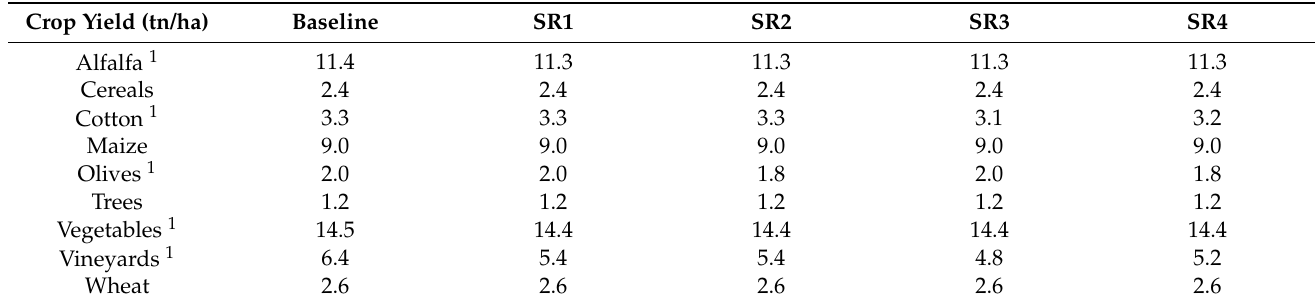
Table 6. Mean annual crop yields in (tn/ha) for the various scenarios (period